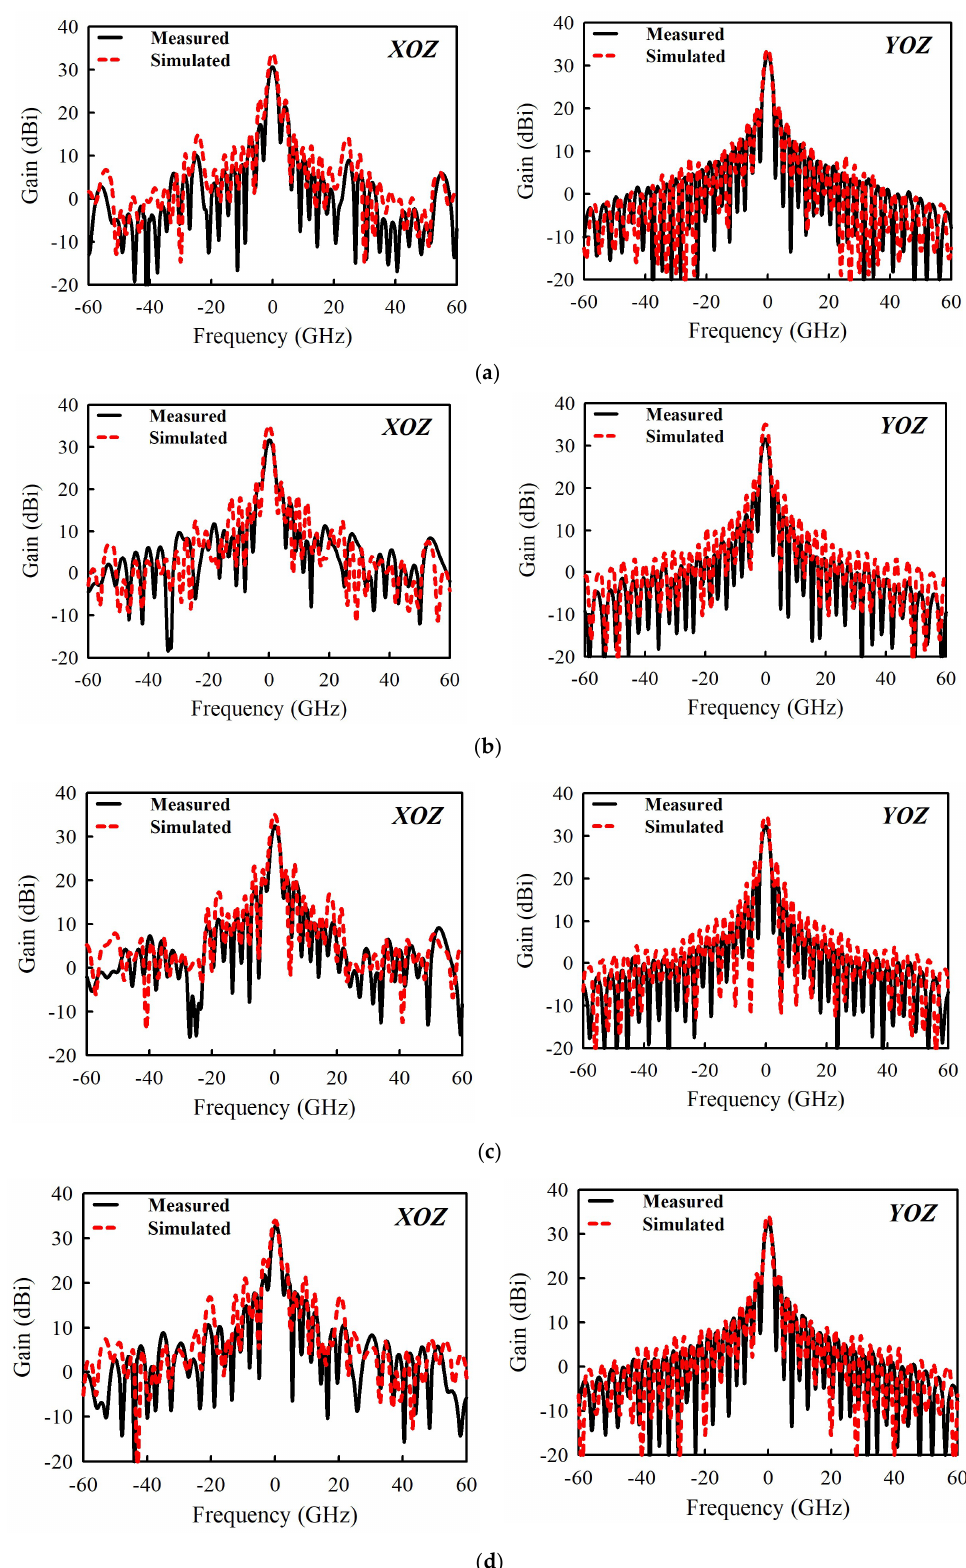
Figure 10. ( a ) Reflection coefficient. ( b ) Gain and efficiency.